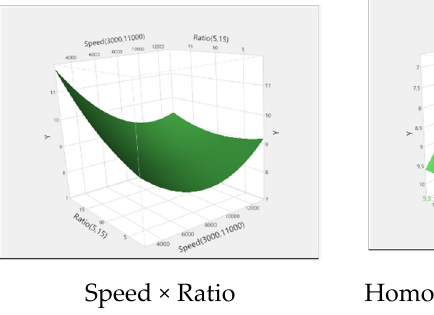
Figure 5. Interaction effects of pairs of factors on the response.